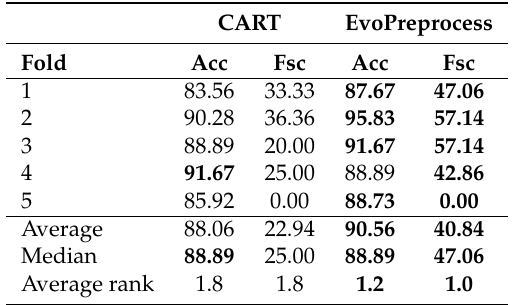
Table 1. Accuracy and F-score results of weighting. The best values are